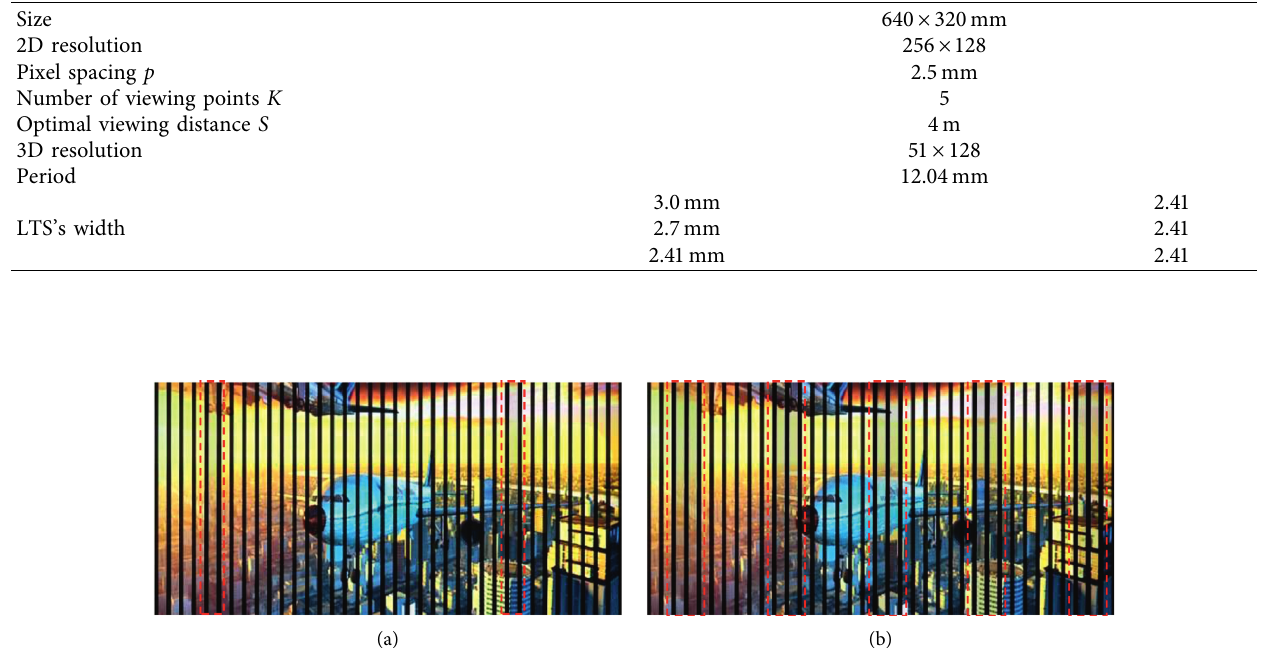
Figure 4: Comparison of experimental results. (a) Diazone of prototype 1: light, thin, and sparse; (b) diazone of prototype 2: prominent, wide, and